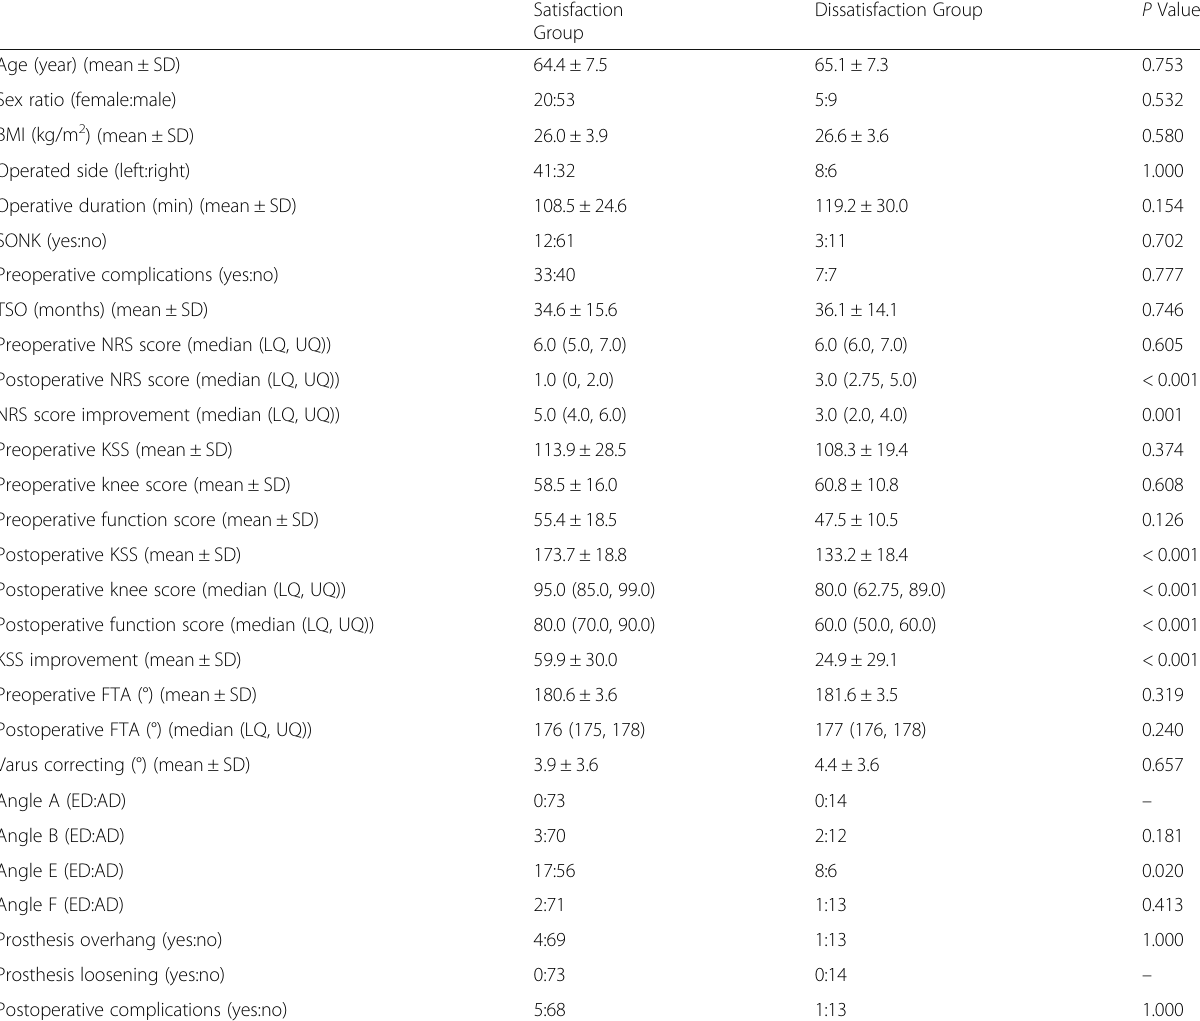
Table 4 Clinical features of the satisfaction group and the dissatisfaction group